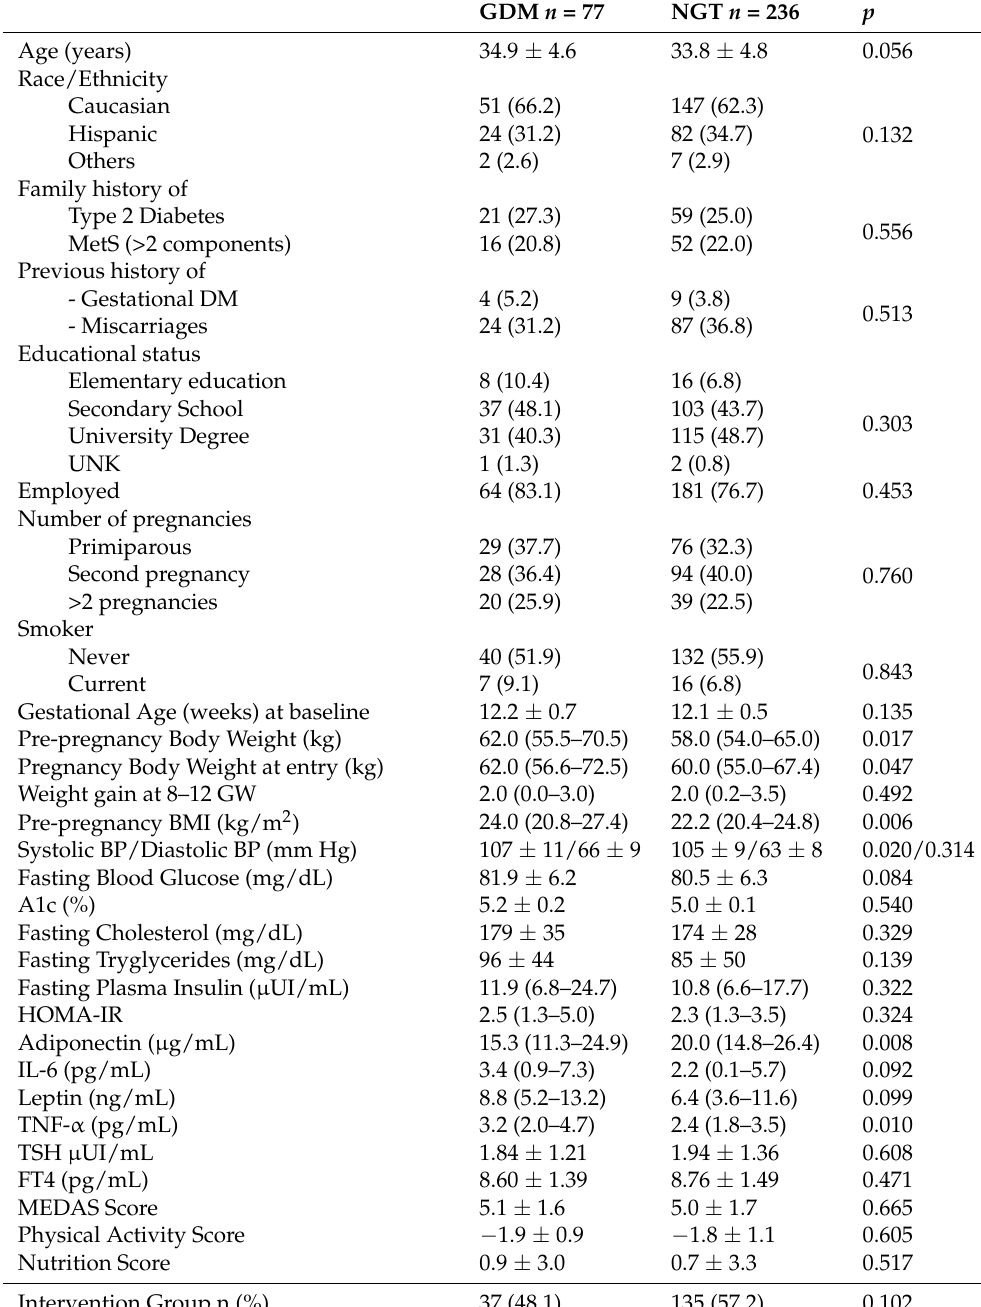
Table 2. Comparison of baseline (at 8–12 gestational weeks) characteristics of women with gestational diabetes mellitus (GDM) and normal glucose tolerance (NGT)